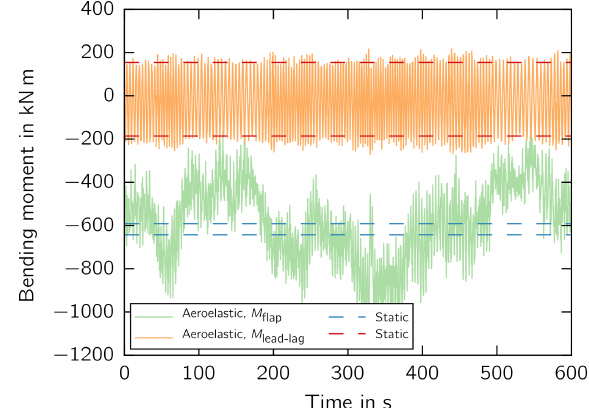
Figure 6. Markov matrix of a 600s aeroelastic simulation at z = 10 . 2m and v = 9ms − 1 .